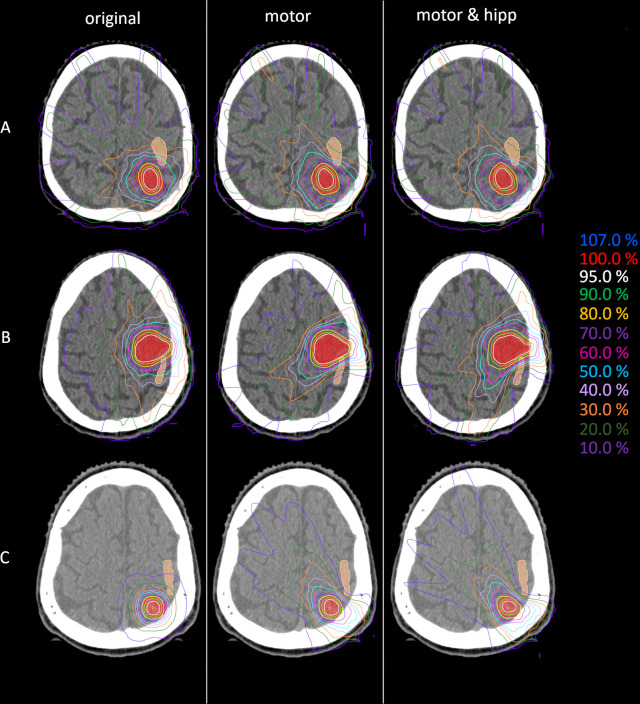
Example dose distributions for the original (left), motor (middle) and motor&hipp (right) plans for three different patients and planning scenarios. (A) patient treated originally by static beams, (B) patient treated originally with intensity-modulated radiotherapy (IMRT), (C) patient treated originally with non-coplanar arcs. The planning target volume (PTV) is delineated by the red filled contour, the nTMS-based motor cortex in skin color.